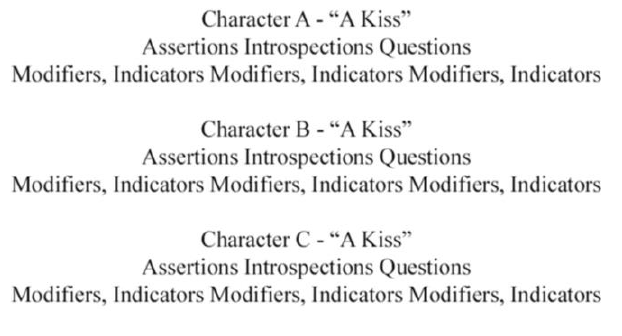
Figure 4. Narrative elements.